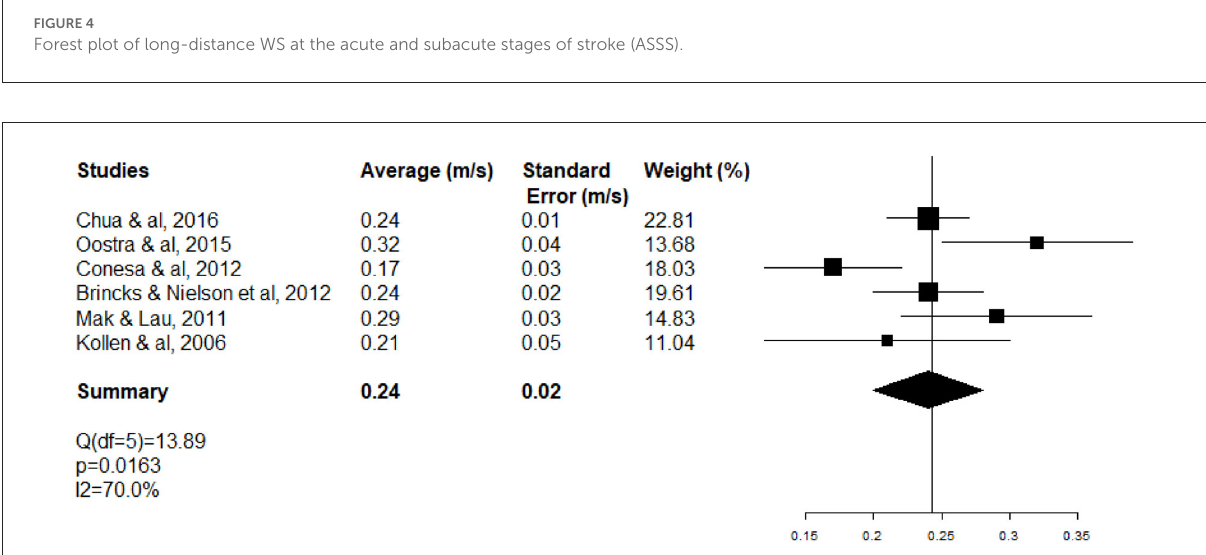
FIGURE5 Forest plot of WS of rehabilitation inpatients at the acute and subacute stage of stroke